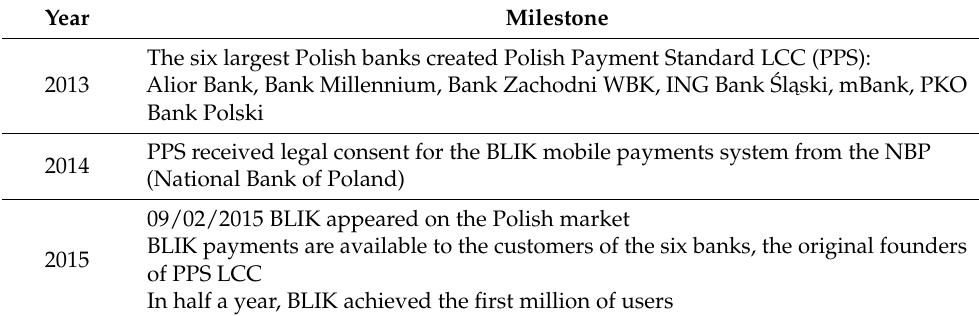
Table 6. Milestones in the evolution of BLIK.